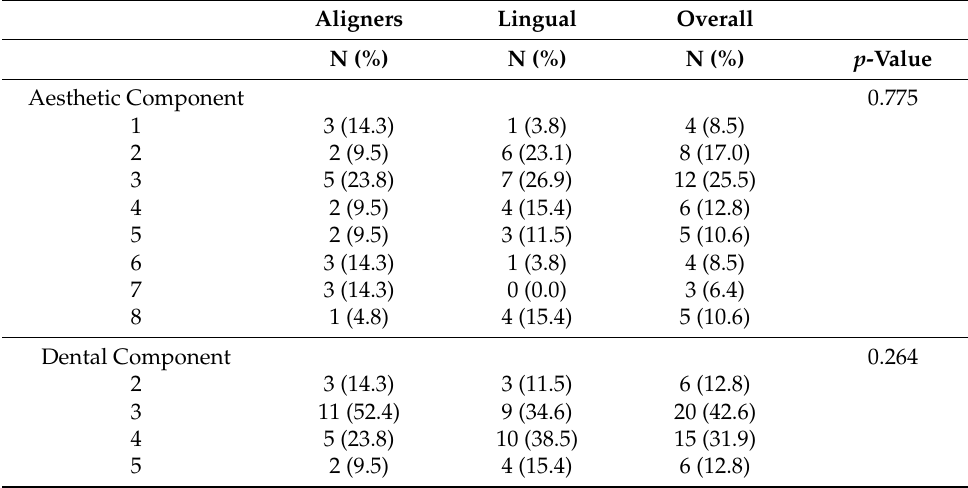
Table 3. Aesthetic and dental component of IOTN index by